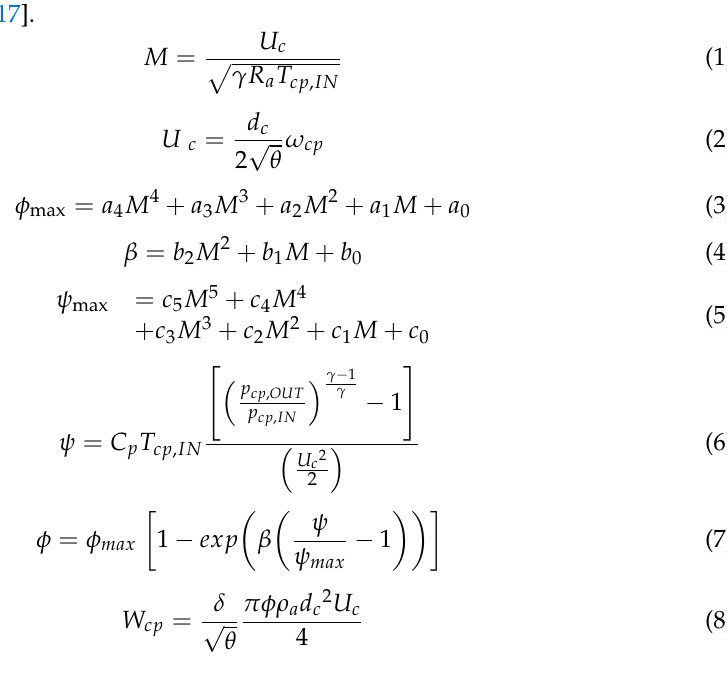
Table 2. Coefficient values of air compressor